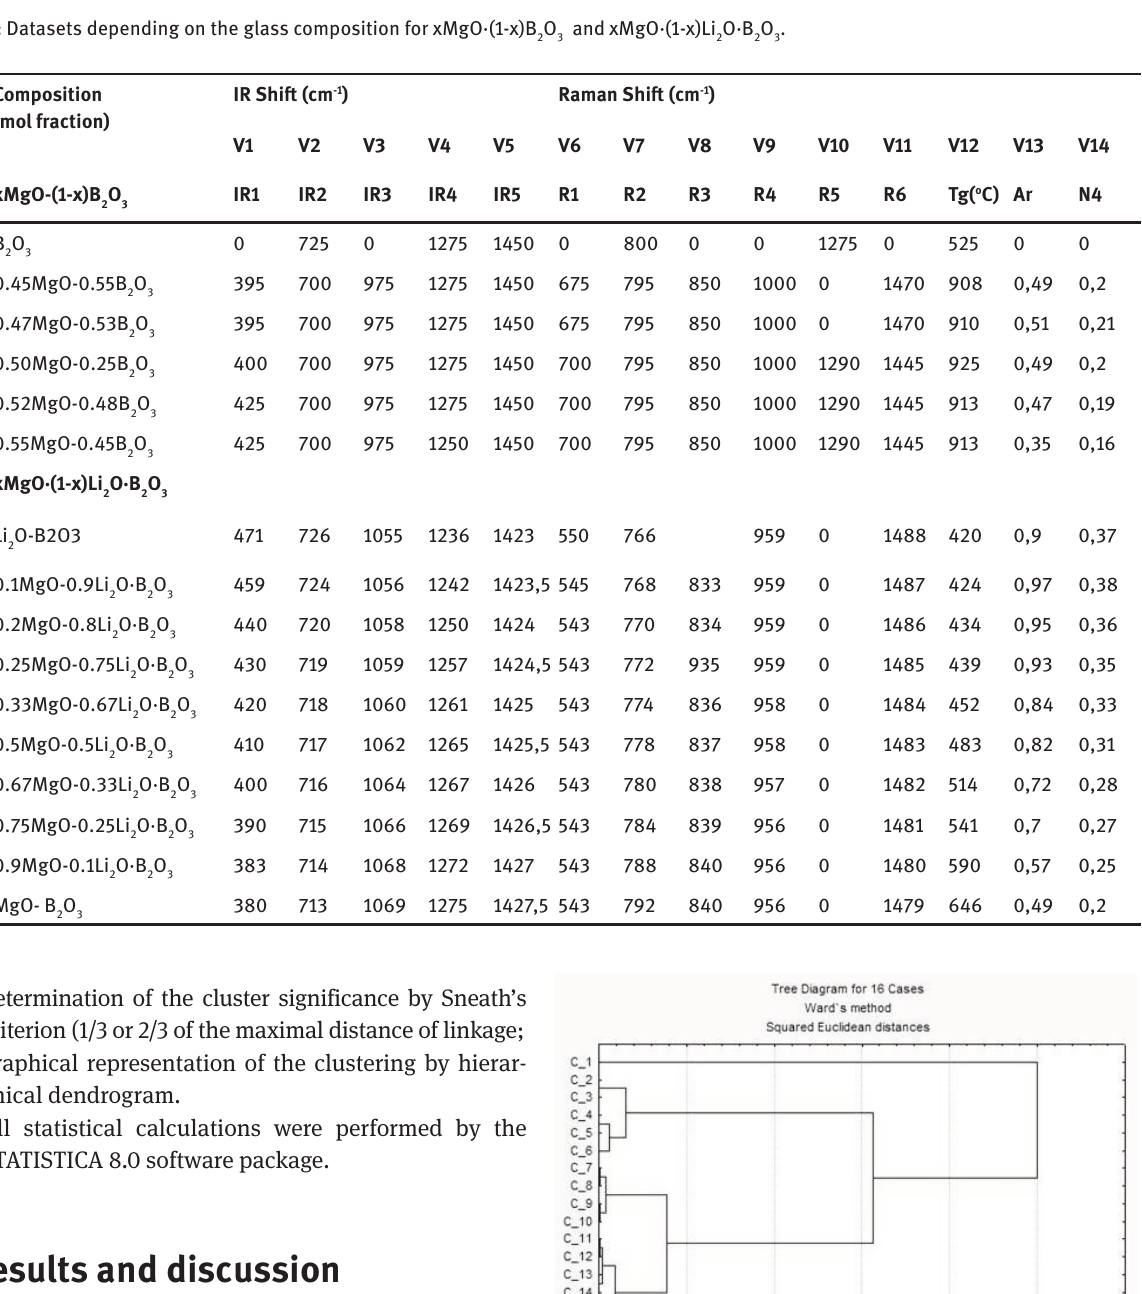
O and xMgO·(1-x)Li 2 3